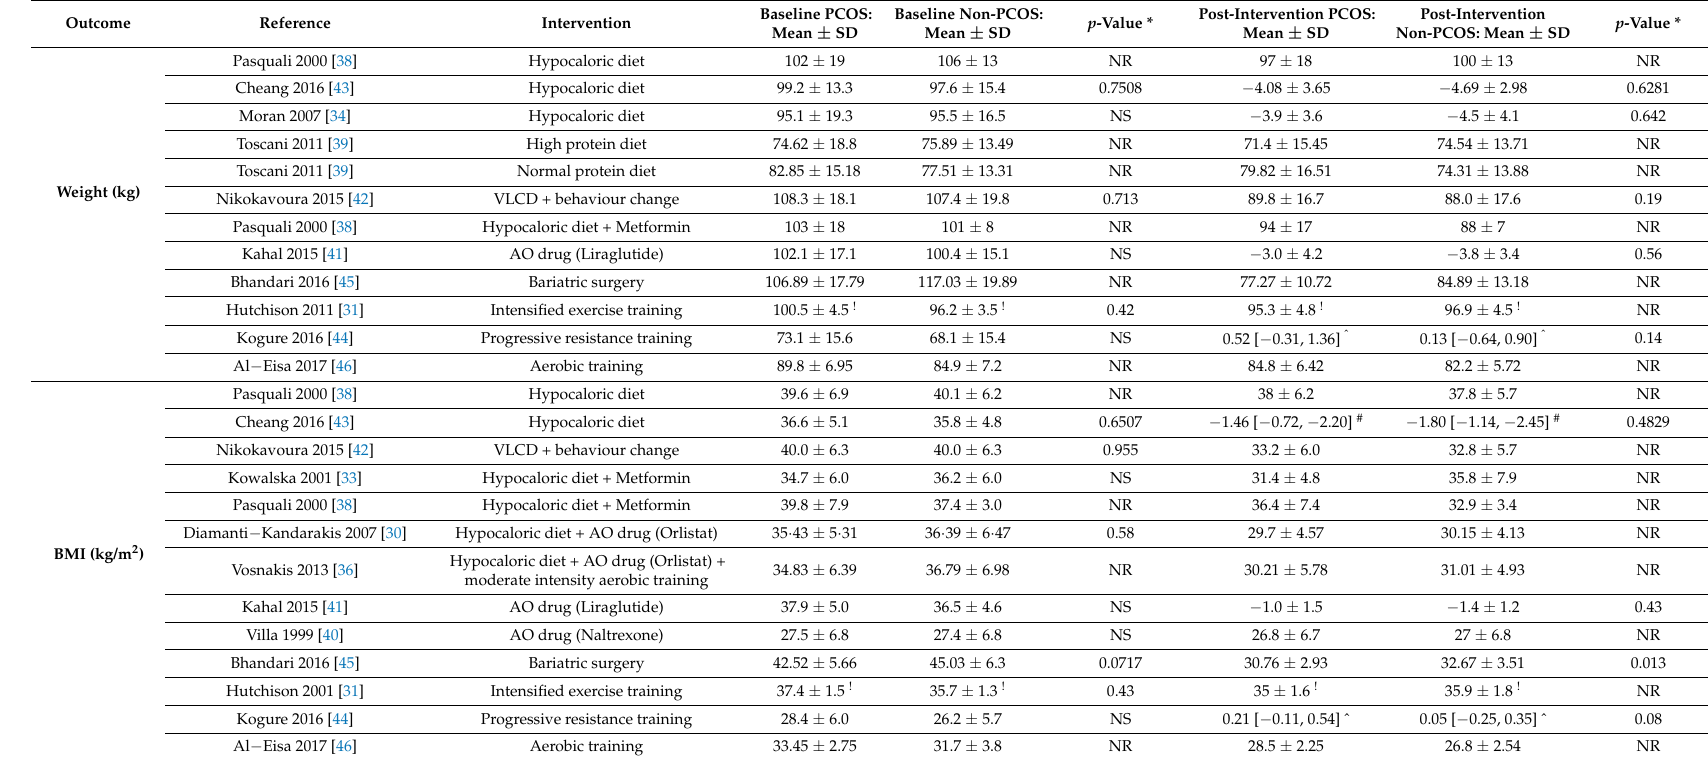
Table 2. Anthropometric